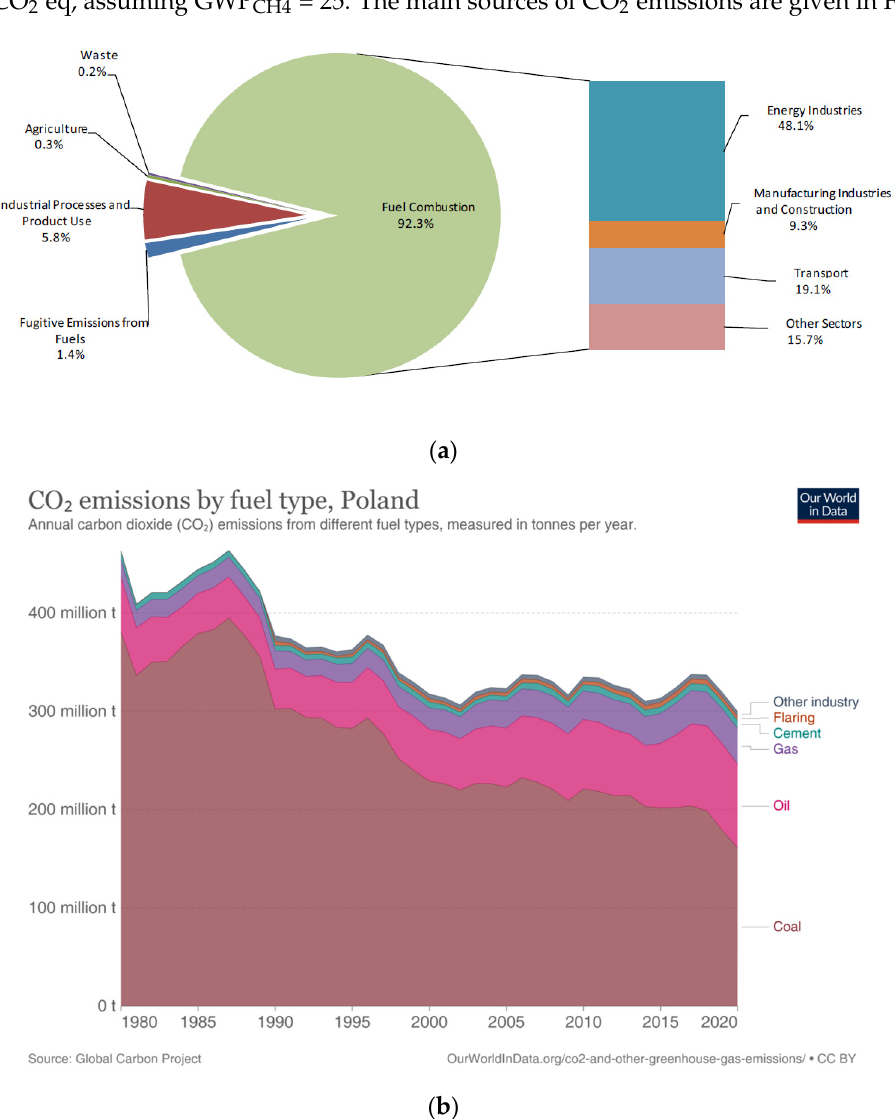
Figure 1. ( a ) CO 2 emissions excluding LULUCF by sectors in 2018 [18], ( b ) CO 2 emissions by fuel type [19] in